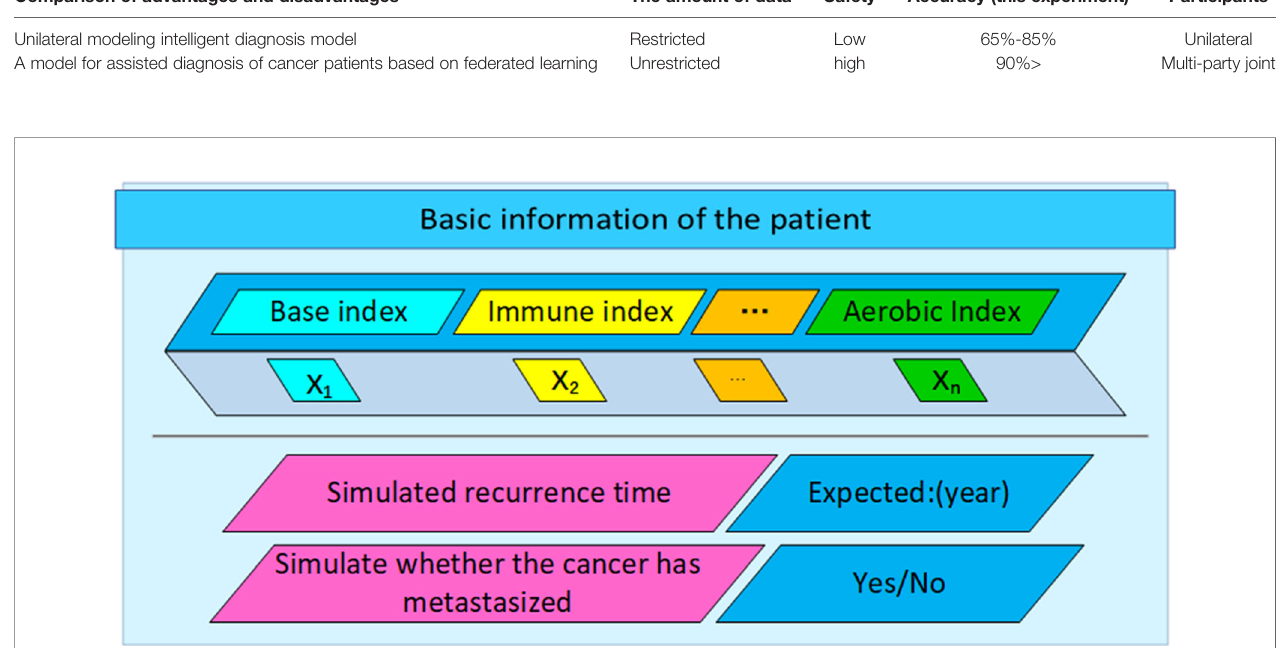
TABLE 5 | Model comparison. Comparison of advantages and disadvantages